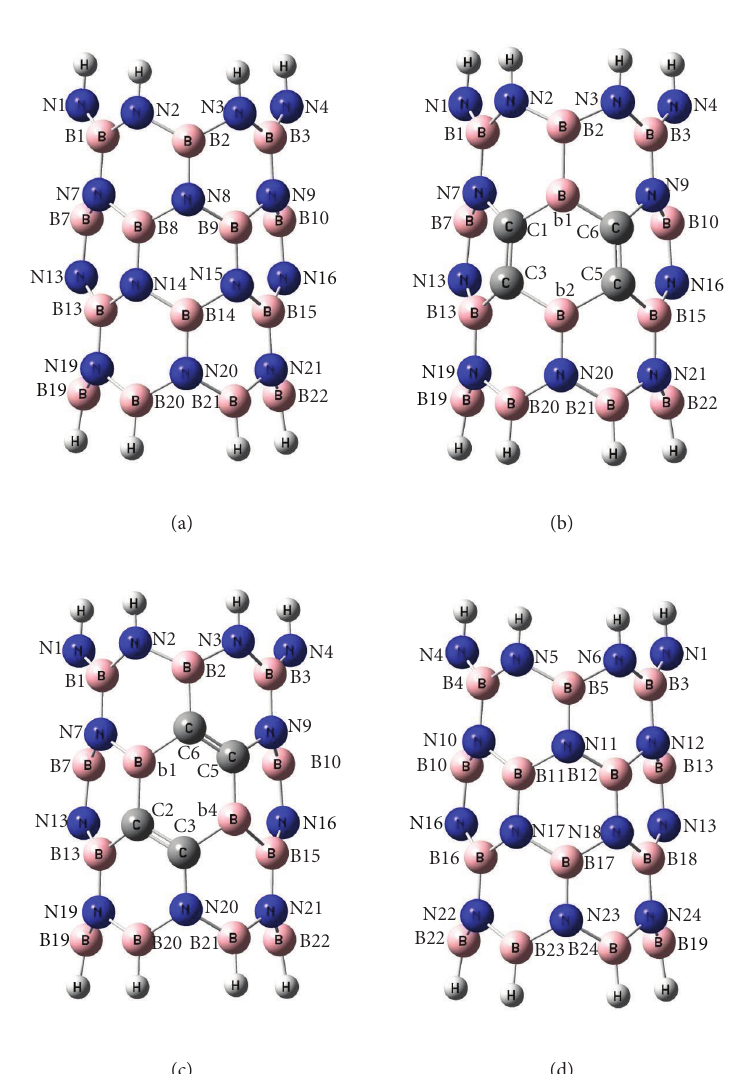
F 1: Typical geometric structures pure and diborinin-doped (6,0) single-walled zigzag BNNT; (a) front side of pure model, (b) and (c) front side of DBD-BNNTs, and (d) back side of pure and DBD-BNNTs